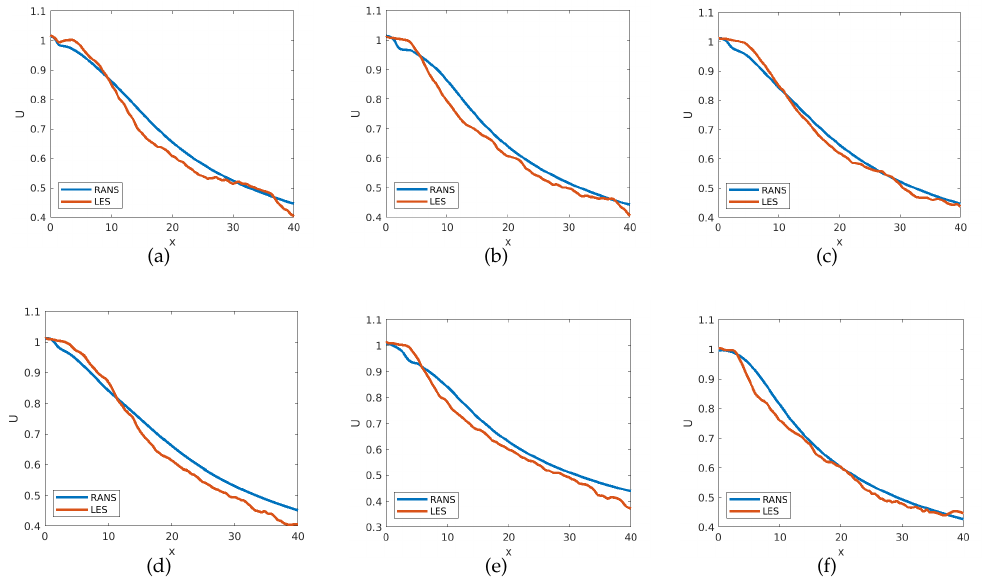
Figure 8. Mean streamwise velocity along the jet centerline: ( a ) d = 0.65 D j , L = 5 D j ; ( b ) d = 0.75 D j , L = 4 D j ; ( c ) d = 0.75 D j , L = 5 D j ; ( d ) d = 0.75 D j , L = 6 D j ; ( e ) d = 1.0 D j , L = 5 D j ; ( f ) no